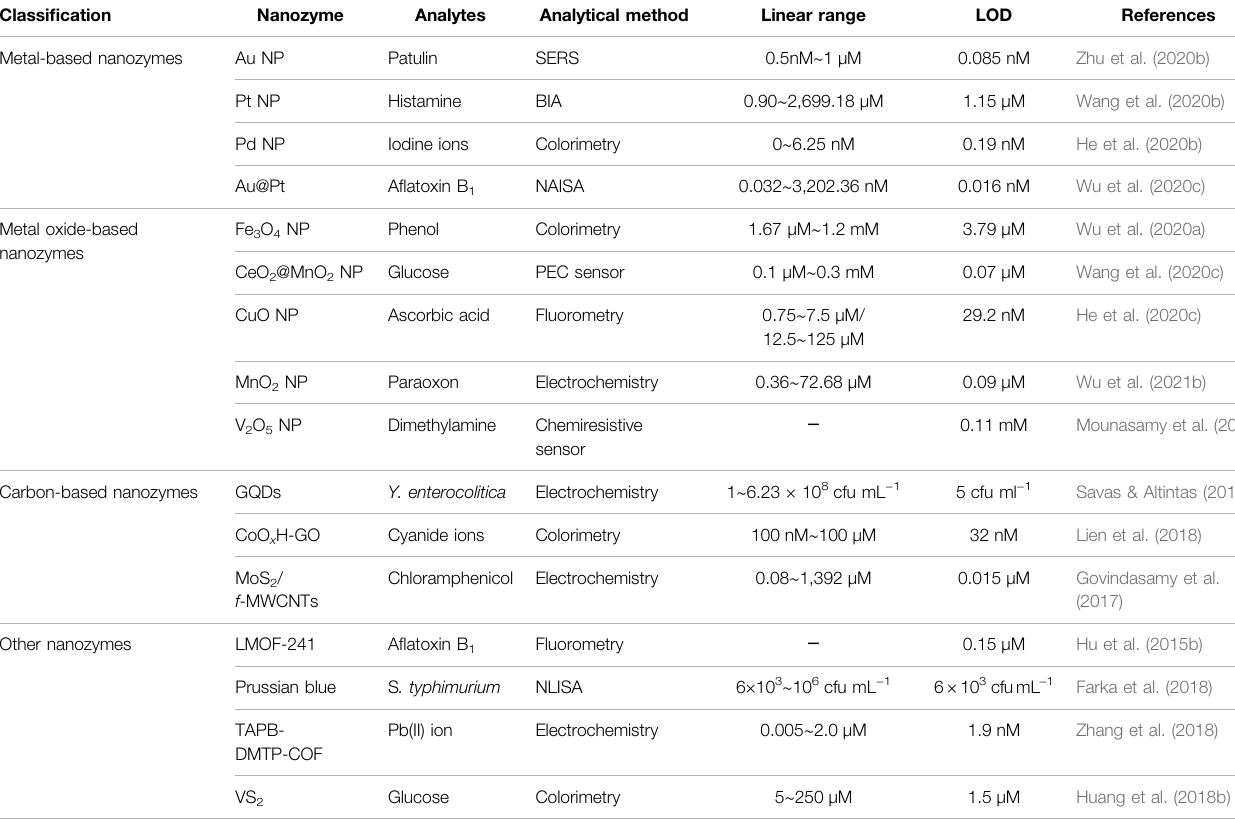
TABLE 1 | Reported nanozyme-based methods in food safety